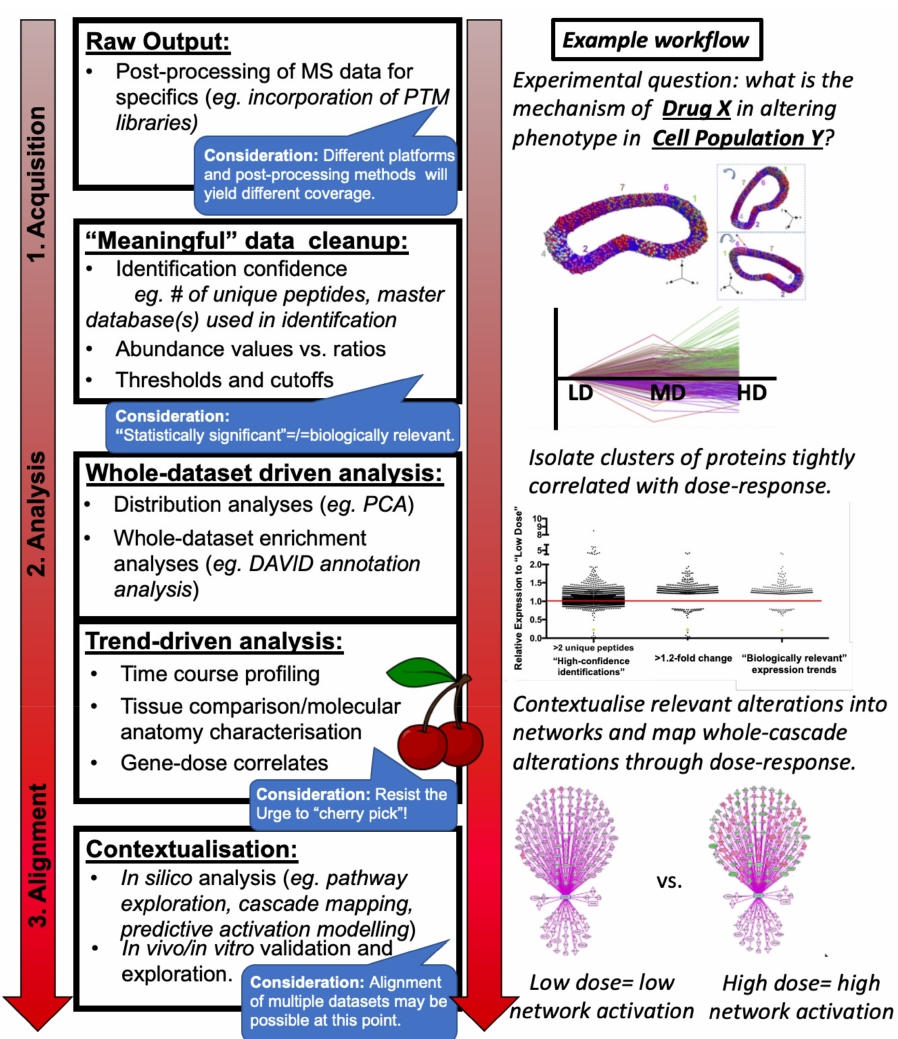
Figure 1. Schematic summarising workflows described to optimise -omics style experimental design and data